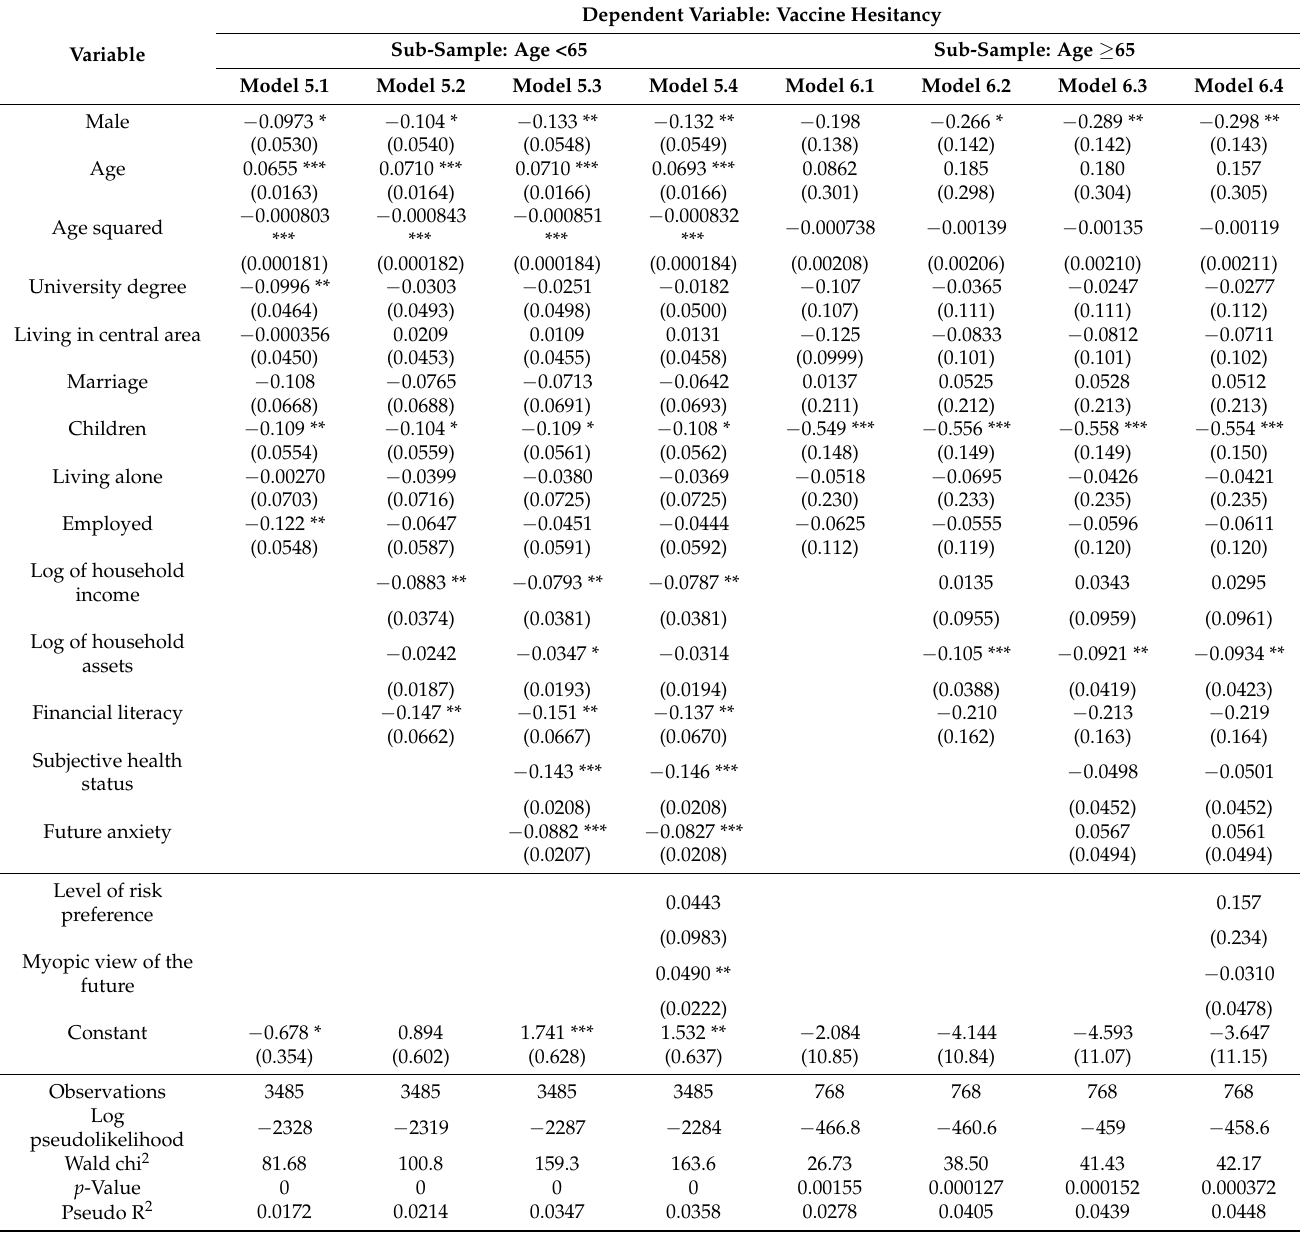
Table 8. Probit model regression results (sub-sample analysis: